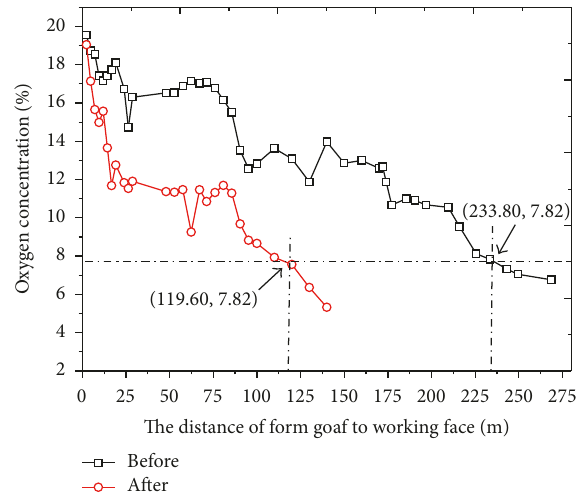
Figure 13: Comparison of oxygen concentrations. After: the oxygen concentration of the goaf after the crossheading was filled up with gelling foam cement material; before: the oxygen concentration of the goaf after the crossheading was filled up with